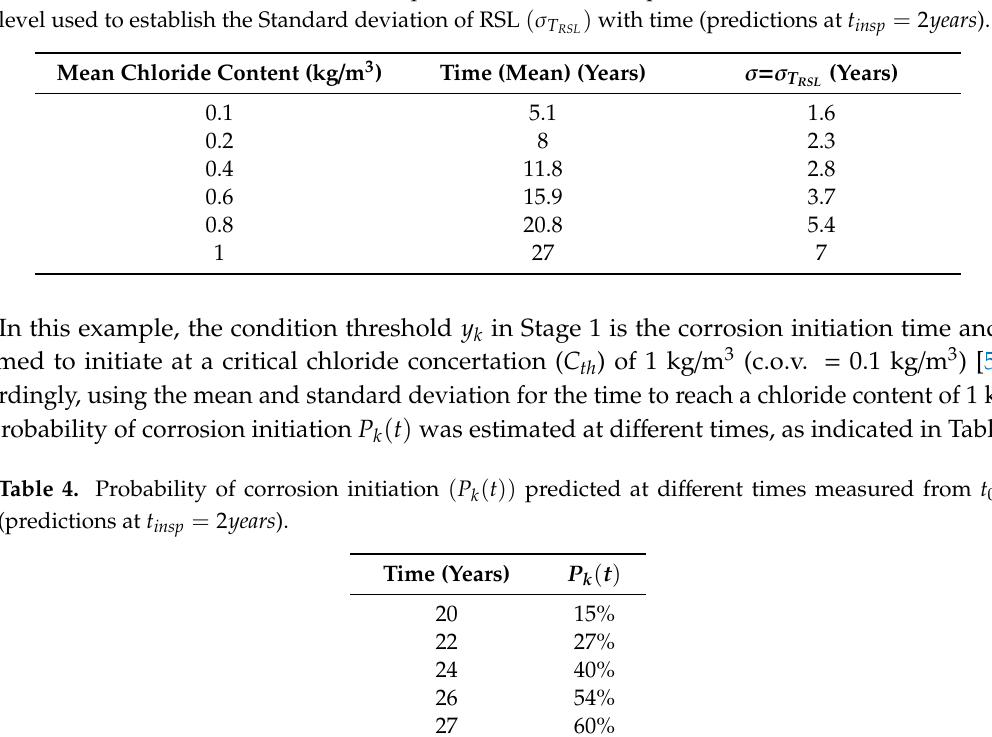
Table 3. Mean and Standard Deviations of predicted time to reach specified chloride content at the rebar level used to establish the Standard deviation of RSL ( σ T